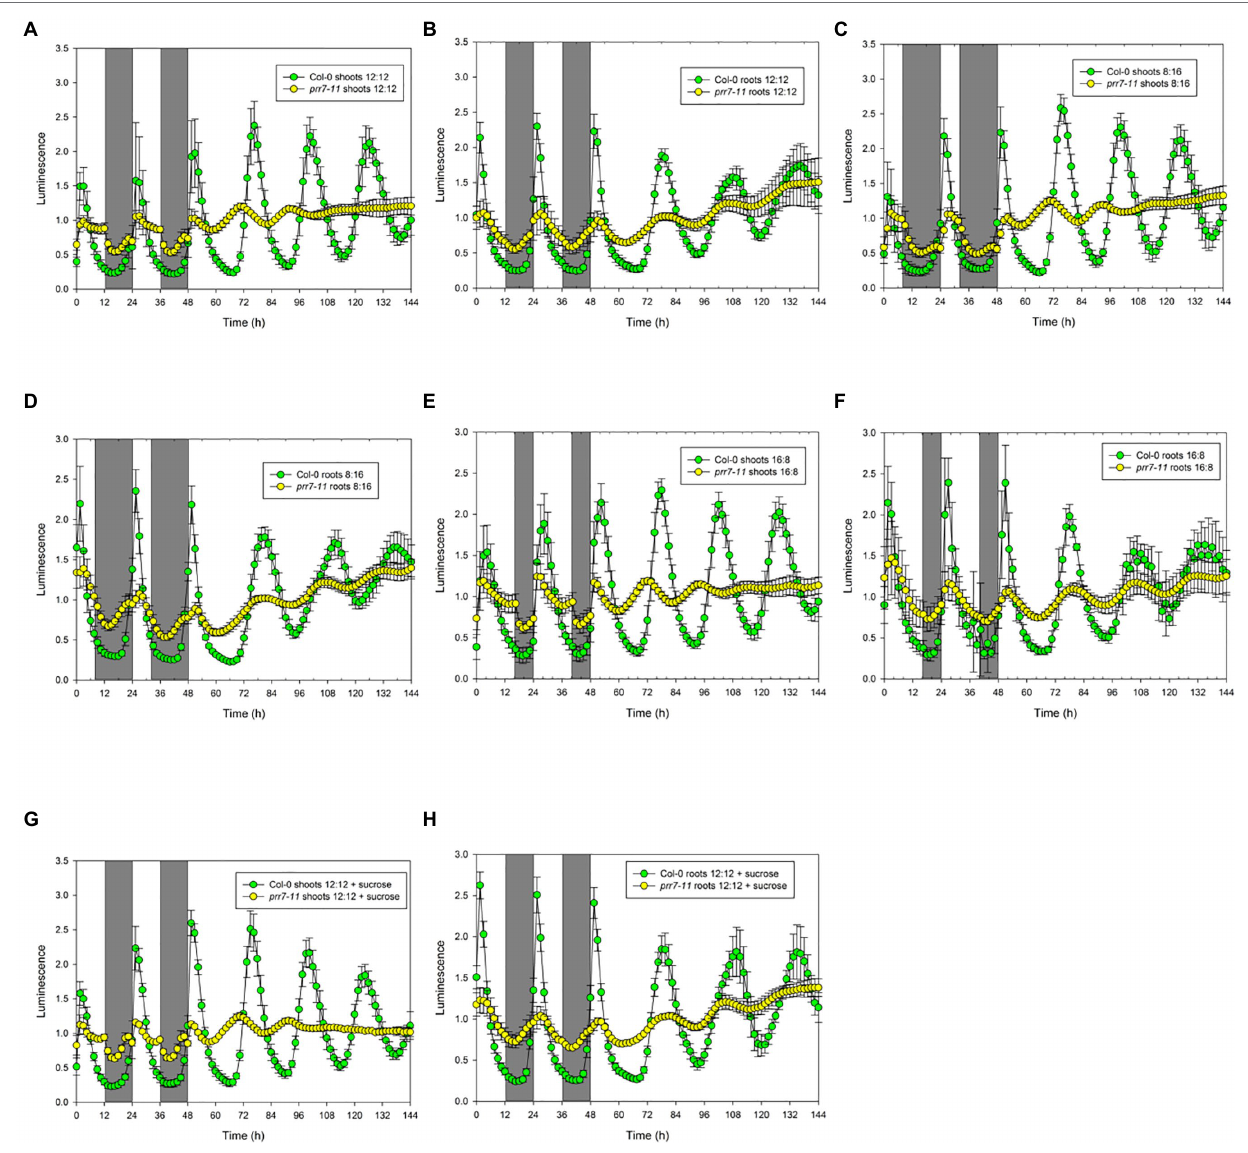
FIGURE 1 | prr7-11 shoots respond to light in LD cycles and are rhythmic in LL. The data show mean ± SD luminescence for Col-0 and prr7-11 shoots (A,C,E,G) and roots (B,D,F,H) expressing CCA1::LUC (n = 16 replicates) in two LD cycles followed by 96 h in LL. Photoperiods: (A,B,G,H) – 12:12; (C,D) – 8:16; and (E,F) – 16:8. Plates in (G) and (H) contained 1% sucrose. Green – Col-0; yellow – prr7-11